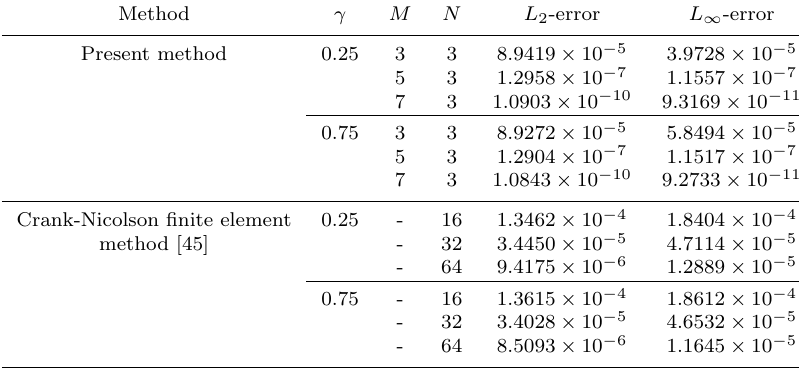
Table 6. Comparison of the L 2 and L ∞ errors for different values of M,γ and β = 1 with methods in [45] on the interval [0 , 1] × [0 , 1] for Example